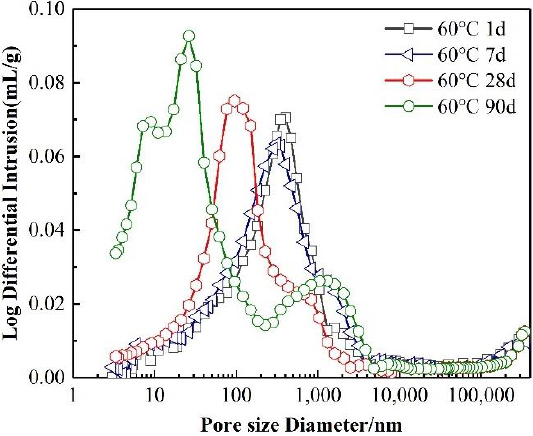
Figure 3. Pore structure of the SRPC at different ages.